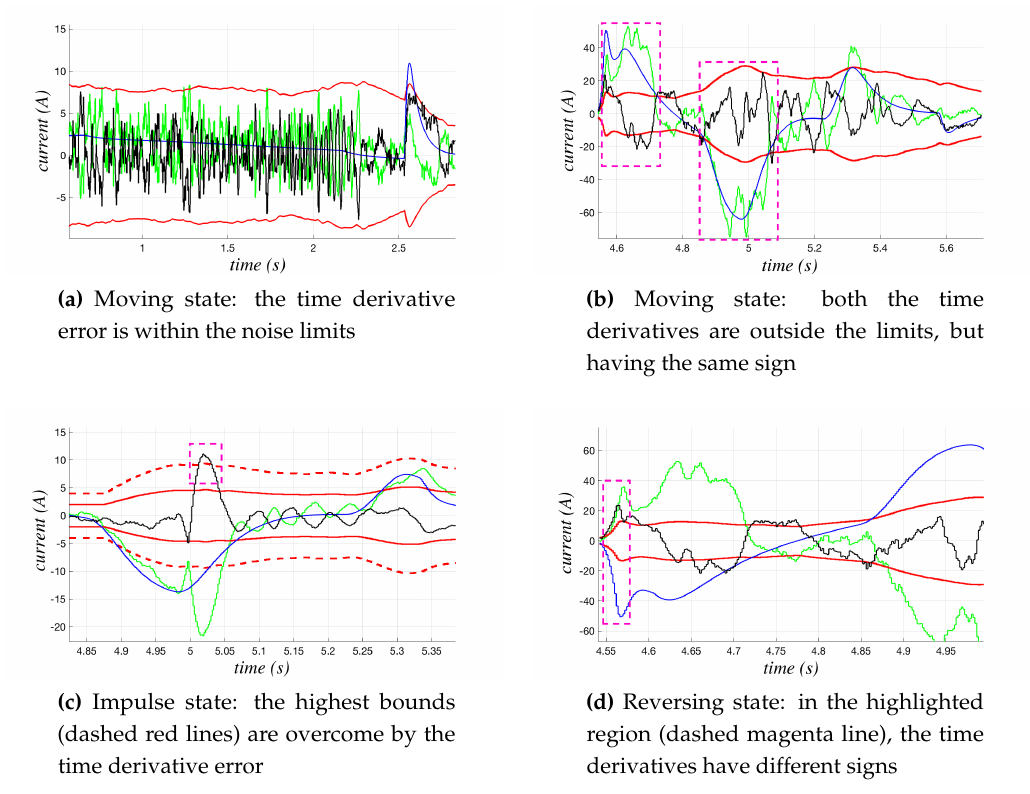
Figure 8. Examples of the behavior of dp _ I i ( t ) and dp _ I DM , i ( t ) in the moving, reversing and impulse states. The solid red lines indicate the Th max and Th min bounds; the green line and the blue one represent dp _ I i ( t ) and I DM , i ( t ) , respectively, and the solid black line their difference, computed as dp _ I i ( t ) - dp _ I DM , i ( t )